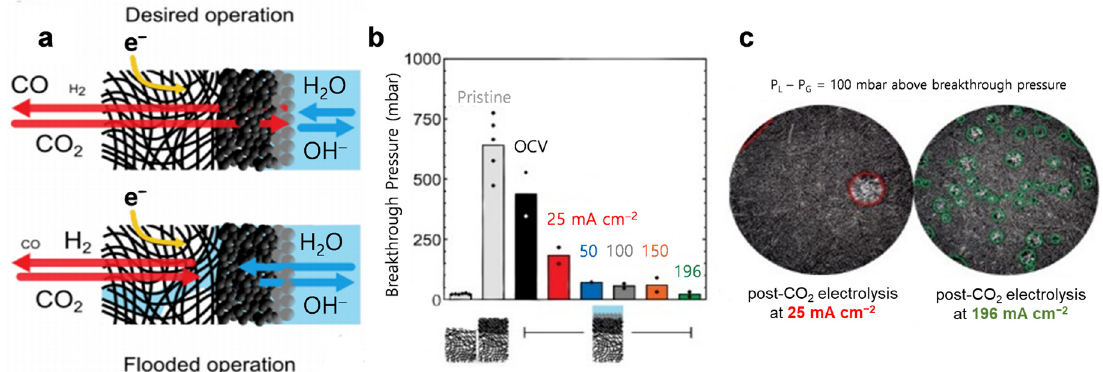
Figure 12. Degradation of the gas diffusion layers (GDL): ( a ) a schematic diagram showing the process of electrode flooding Figure 12 during electrochemical CO 2 reduction; ( b ) the effects of current density upon GDL degradation; ( c ) a visualization of GDL degradation at different applied current densities (reproduced with permission from ref. [93], copyright 2020, WILEY